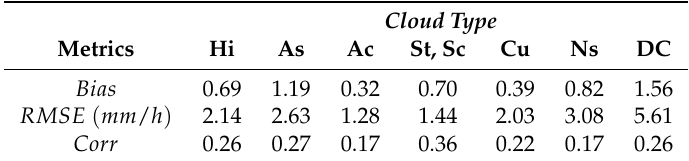
Table 5. Evaluation of PERSIANN-CCS across the United States for July 2018; MRMS dataset is used as a